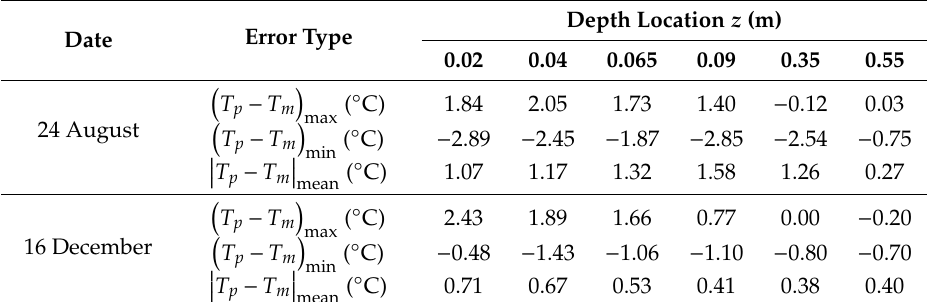
Table 4. Errors between the predicted and measured temperatures of various depth